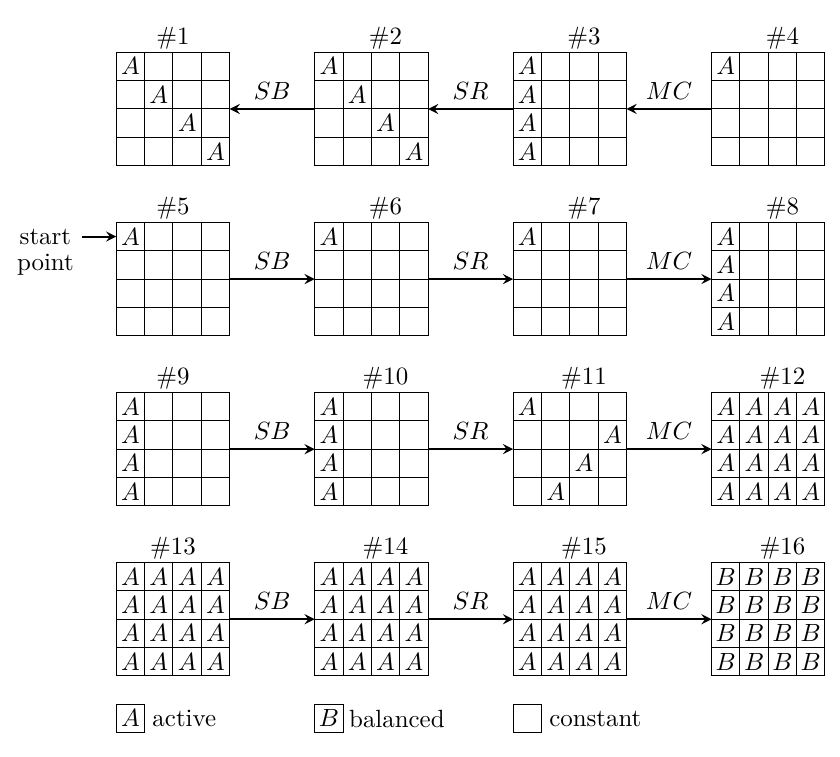
Figure 4: 4-Round integral distinguisher for